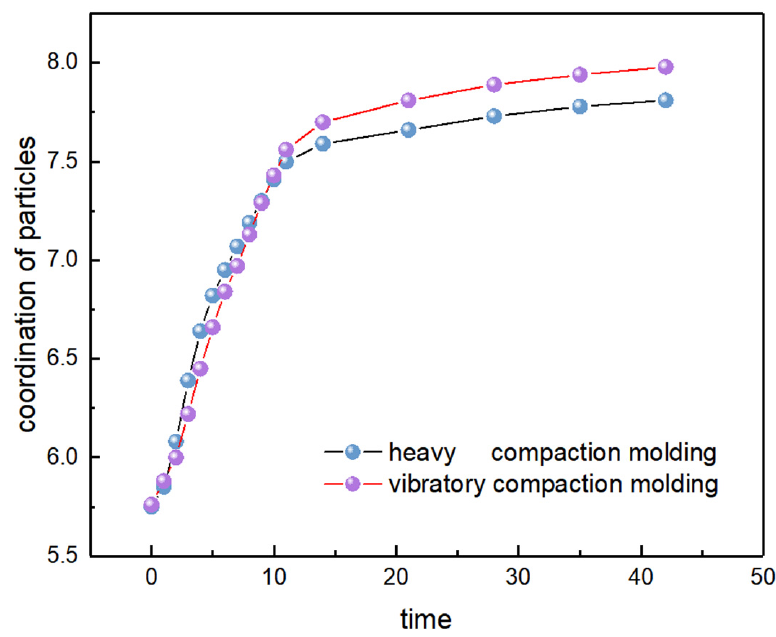
Figure 10. Variation in coordination numbers.